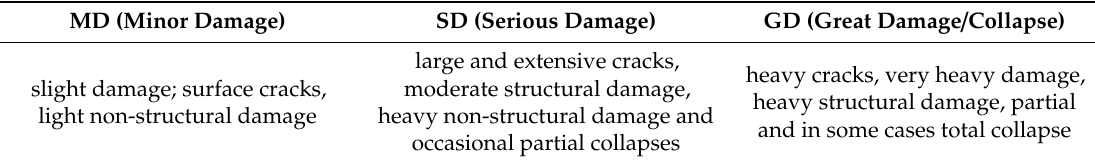
Table 1. Level of damage by historical earthquakes, distinguishing among three different classes of damage.